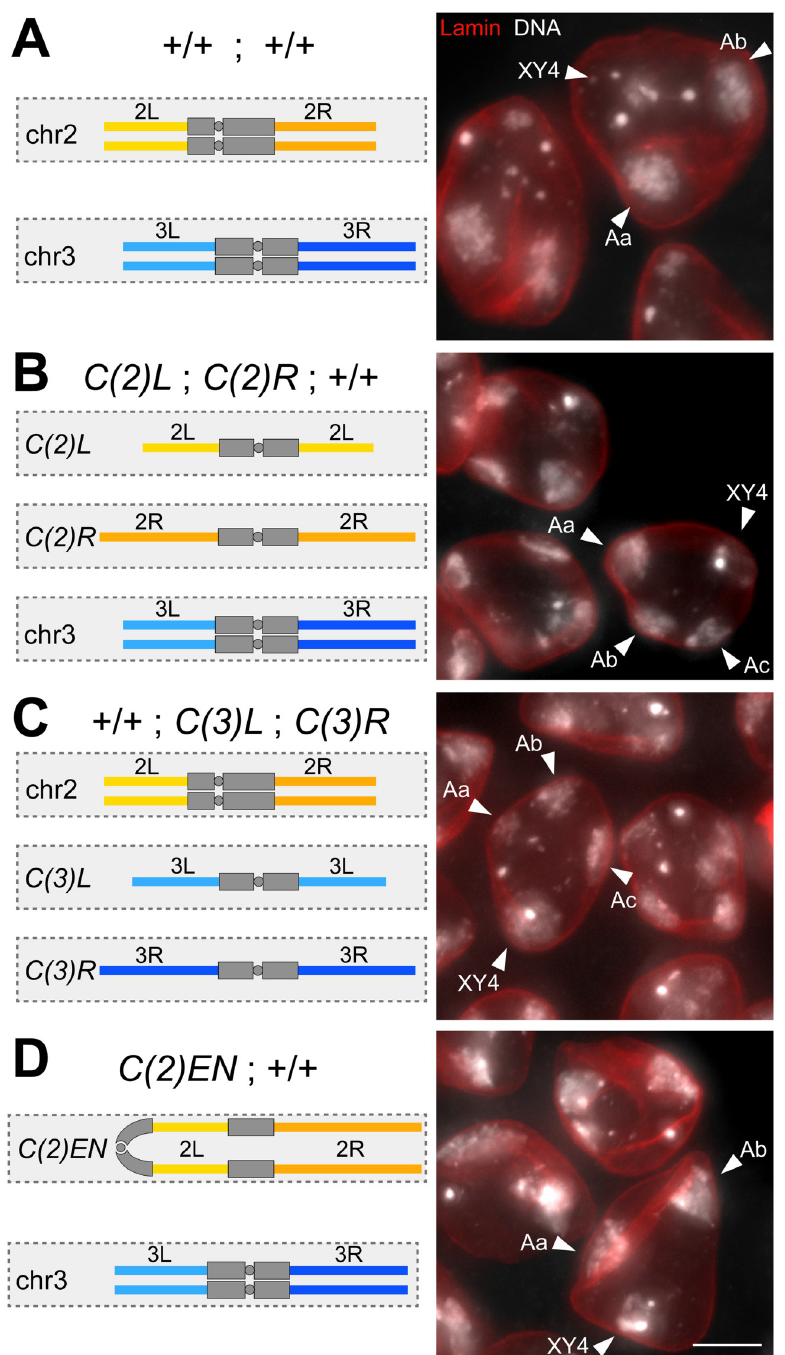
Fig 1. Chromosome territories in spermatocytes with compound chromosomes. ( A-D ) S5 spermatocytes with either the wild-type karyotype ( A ) or the indicated compound chromosomes ( B-D ) were labeled with anti-Lamin Dm0 and a DNA stain. In the schemes on the left, the chromosome territories formed by large autosomes are represented by boxes (dashed outline, light grey shading) and the structure of these autosome is illustrated (euchromatin in color, heterochromatin in dark grey). Arrowheads in the micrographs from squash preparations on the right indicate large autosomal territories (Aa, Ab, Ac) as well as the additional territory (XY4) formed by the sex chromosomes and chr4. Scale bar = 5 μ